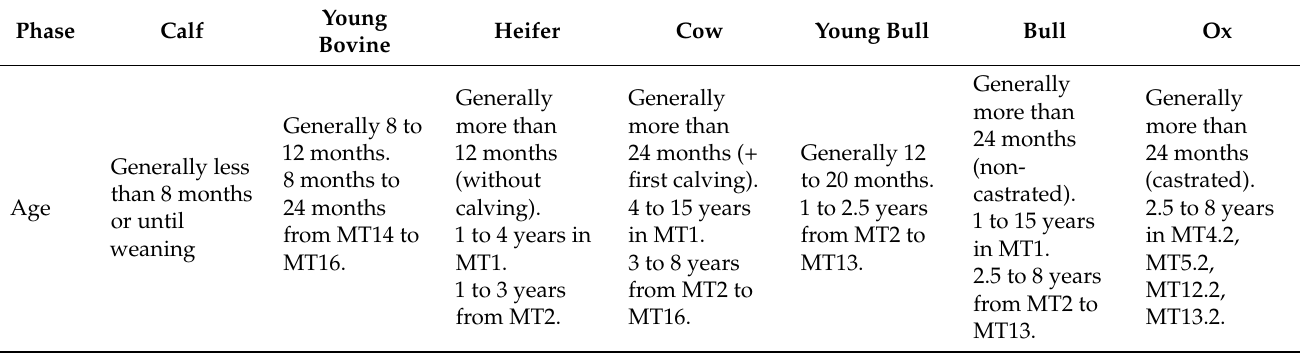
Table A2. Animal profile phase